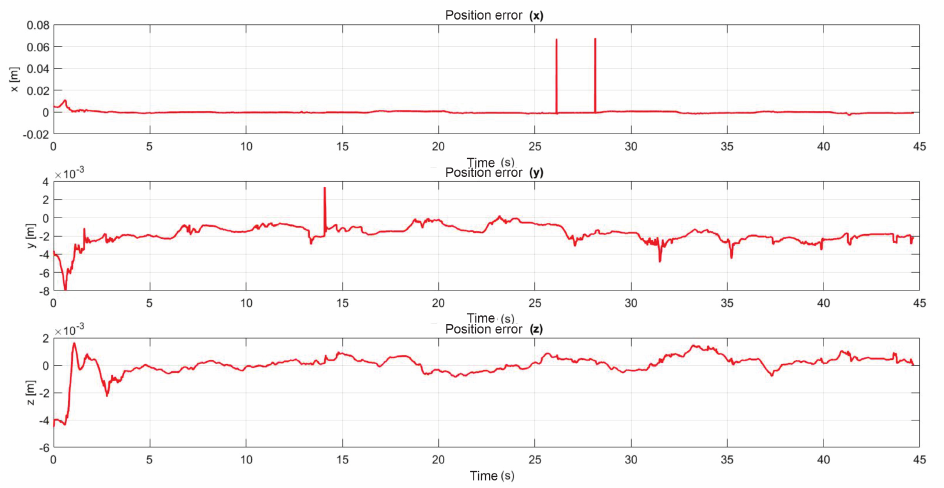
Figure 30. Position error of left haptic device: exercise 3.